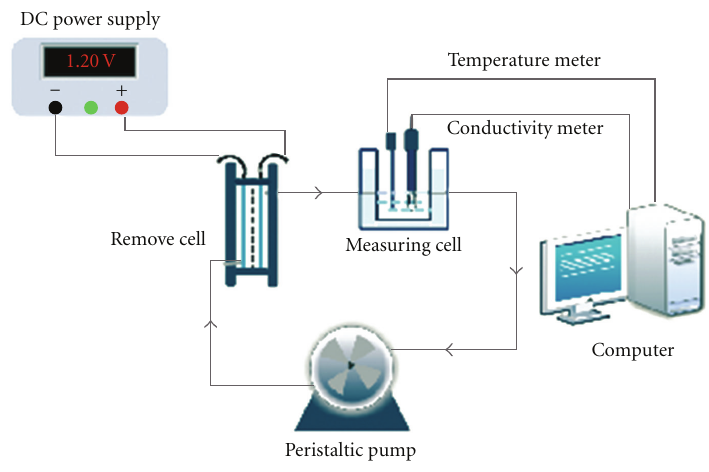
Figure 1: Schematics of batch-mode